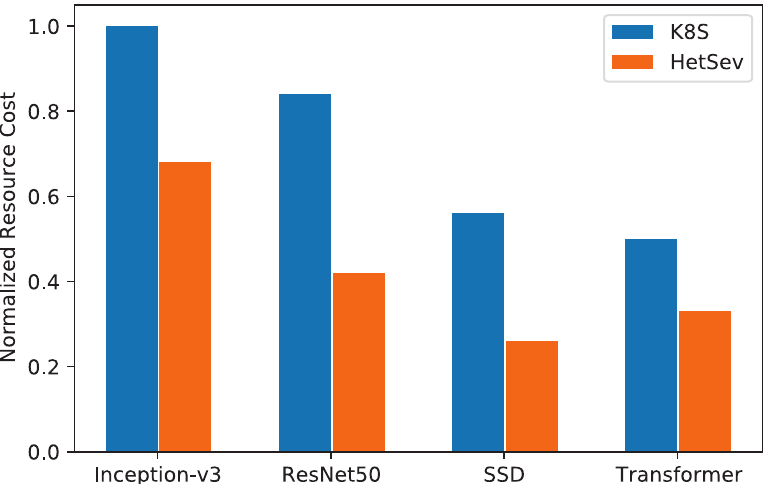
Figure 7. Total resource cost (normalized with respect to the maximum resource cost) for all four ML model services when run with default K8S and